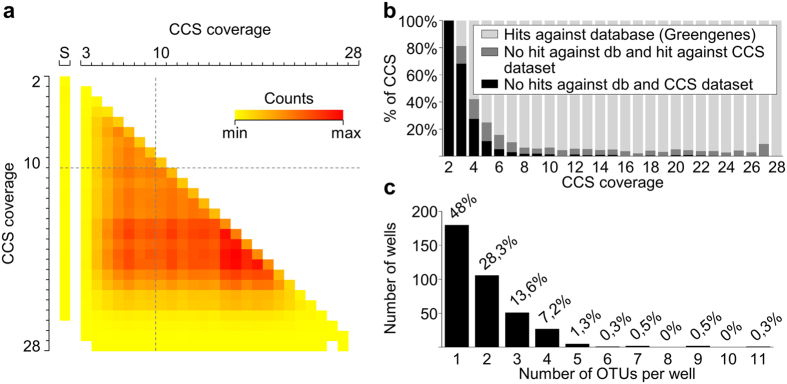
Sequence reliability filter maximizes retention of OTUs that might represent true biological sequences in community-based isolates.A quality filter solely based on CCS coverage causes loss of sequences that contain relevant biological information (Supplementary Fig. 5). A low-coverage CCS can be validated regarding its reliability if it has a representative in a 16S rRNA gene database or if it has high similarity to at least one other sequence in the CCS dataset from the same culture collection. (a) Heatmap showing that low-coverage CCSs (<10×) mostly cluster with high-coverage CCSs (≥10×) in the OTU clustering, which raises their reliability. (b) Alignment of CCSs against Greengenes18 16S rRNA gene database and the CCS dataset from the culture collection. The lower the coverage, the higher the number of error-prone CCSs (no hit against Greengenes and no hit against CCS dataset). (c) Number of OTUs per well found after removing error-prone CCSs. S: singletons. db: database.